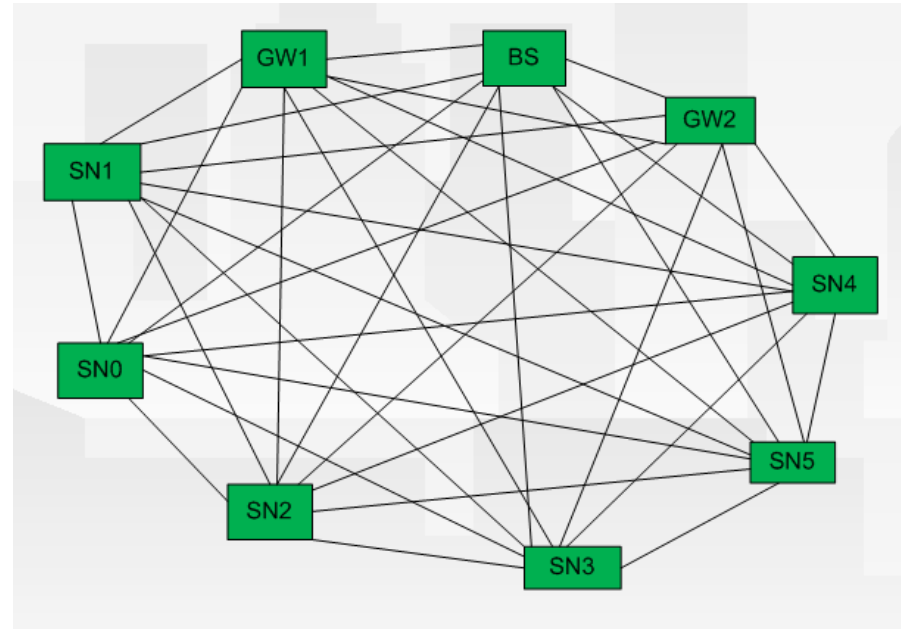
Figure 3. Sensor network with dense topology [39].